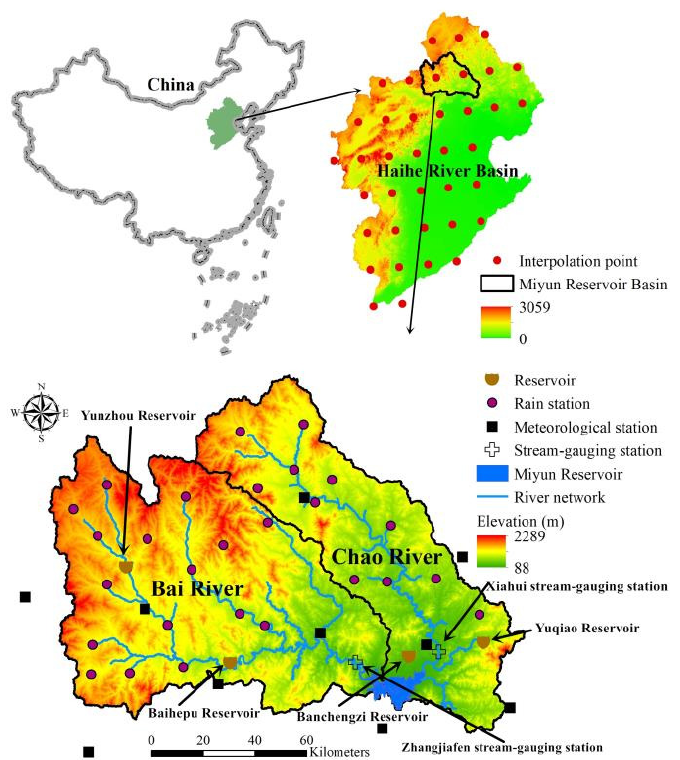
Figure 1. Location of the Miyun Reservoir Watershed (MRW) and hydroclimatic stations.